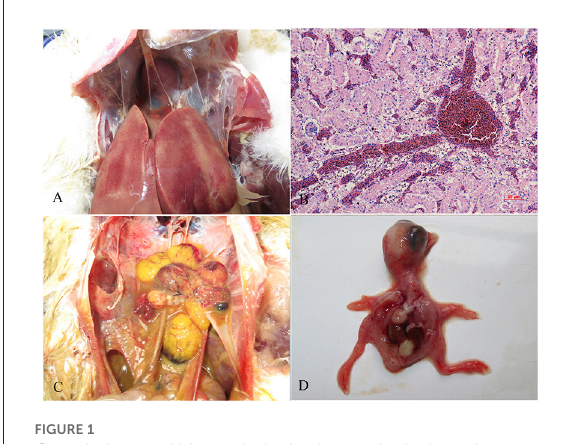
FIGURE1 Gross lesions and histopathologic changes in ducks and embryos. (A) Lesions in the liver, swelling, and congestion; (B) necrosis and fatty degeneration of hepatocytes, and intranuclear inclusions in liver parenchymal cells; (C) lesions in the ovary, follicular dysplasia, necrosis, and rupture; and (D) an infected embryo with subcutaneous hemorrhage.